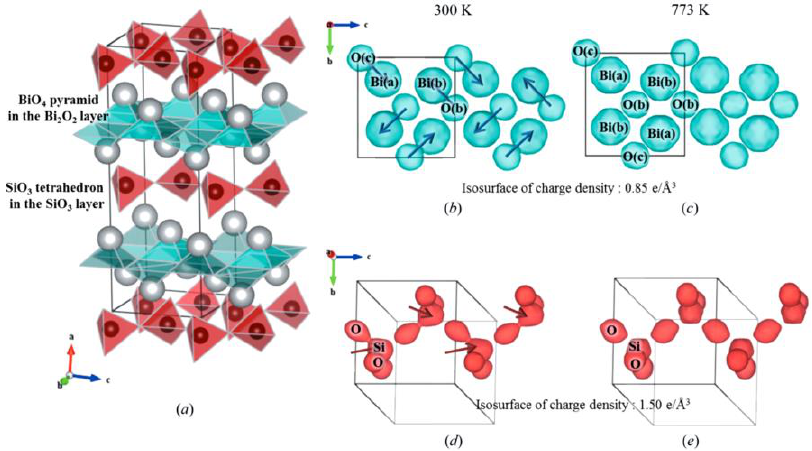
Figure 6. Schematic drawing of the crystal structure of Bi 2 SiO 5 ( a ) and ECD using the MEM distri- bution of the Bi 2 O 2 ( b , c ) and the SiO 3 layer ( d , e ) in the ferroelectric (300 K) and paraelectric (773 K) phases. The isosurface of ECD is 0.85 e Å −3 and 1.50 e Å −3 for the Bi 2 O 2 and the SiO 3 layers, respec- tively. Reproduced with permission from [103]. Copyright 2014 under Creative Commons Attribu- tion (CC-BY) Licence.